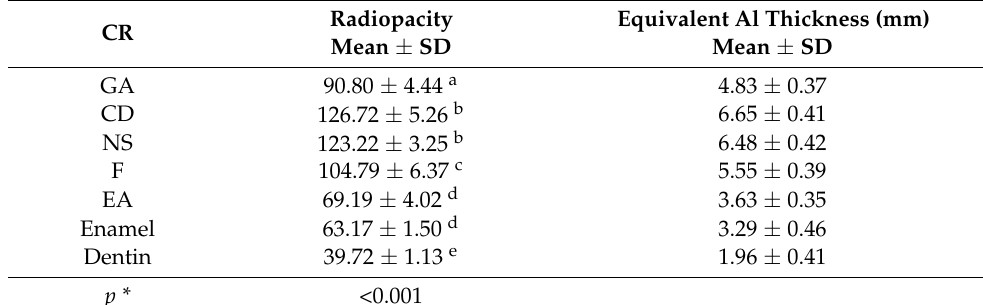
Table 3. Radiopacity and equivalent thickness (mm Al) of CRs and enamel and